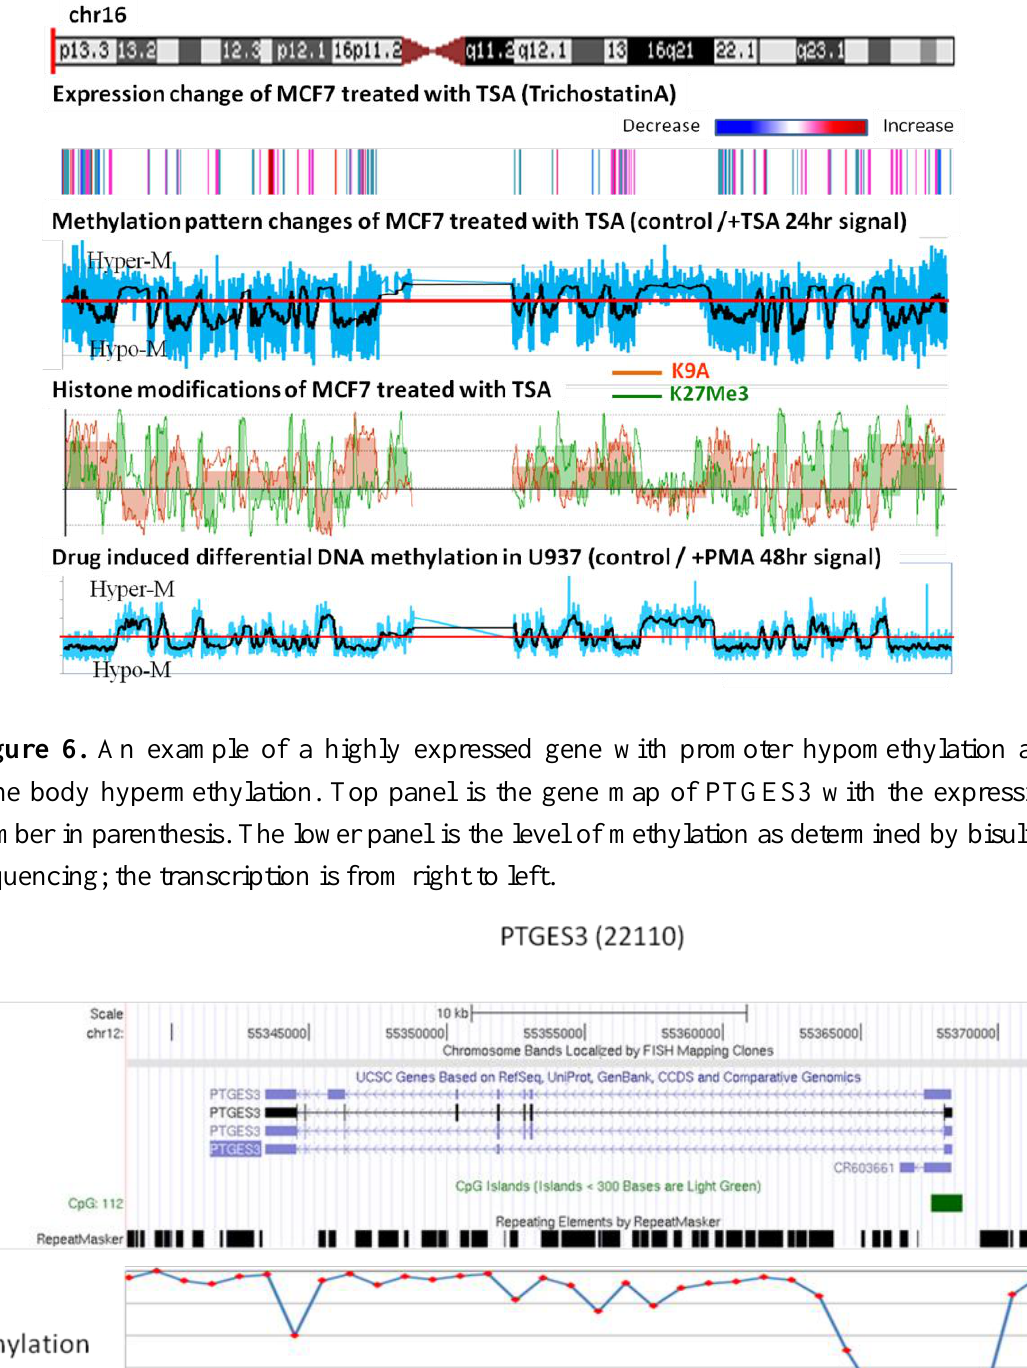
Figure 5. Changes in methylation pattern after drug treatment. Top panel, chromosome 16. Second panel, transcriptome data from the Affymetric analysis of MCF-7 with the level of transcription from high (red) to low (blue). Third panel, differential methylation changes in the MCF-7 genome after treatment with TSA; the blue line represents the ratio of methylation before and after drug treatment and the black line represents the statistical average for the data. Fourth panel, histone modification changes after TSA treatment. En-bloc changes similar to the methylation changes are observed. Fifth panel, changes in methylation pattern of U937 cells before and after the induction of cell differentiation by PMA.